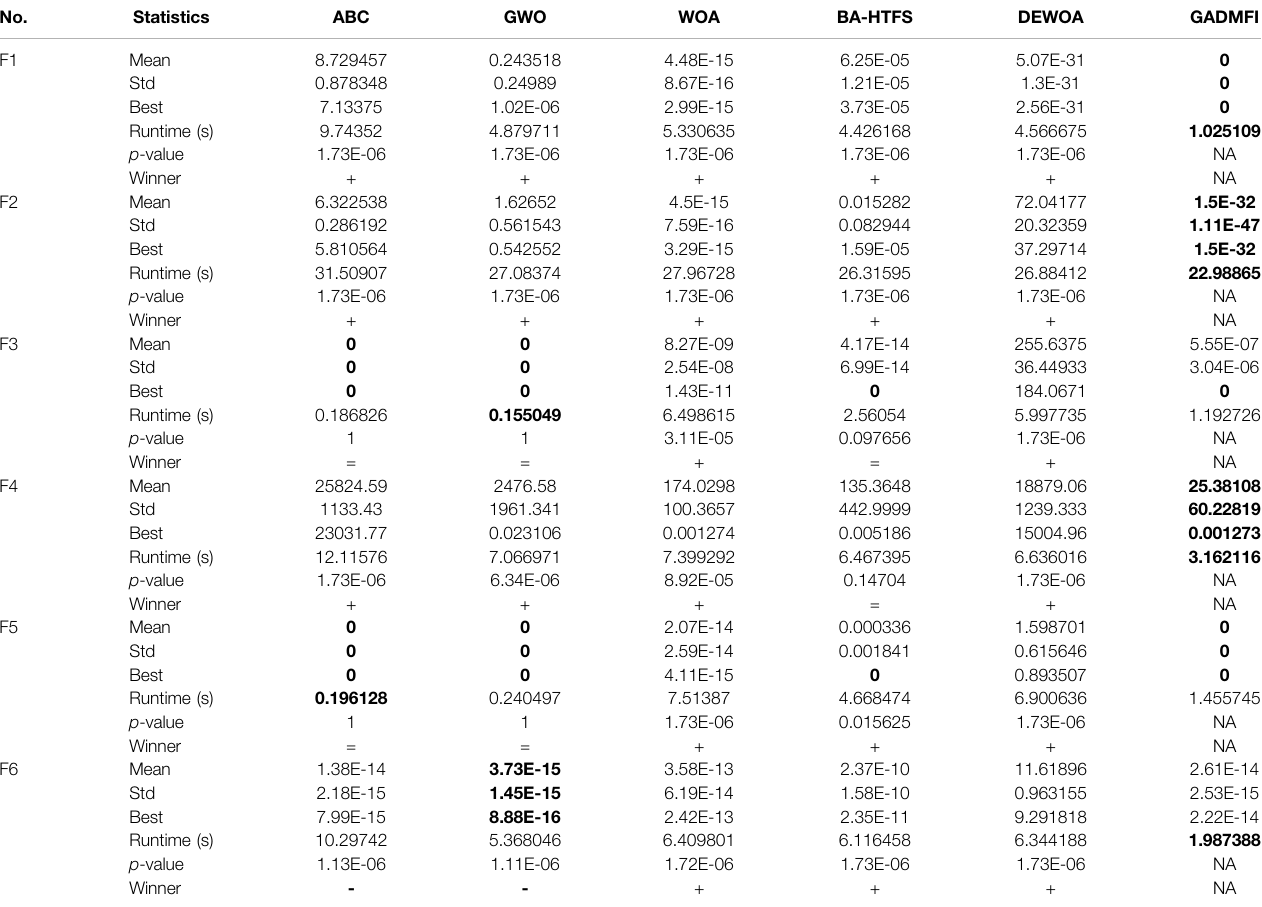
Bold digits are the best statistical performance measures of various